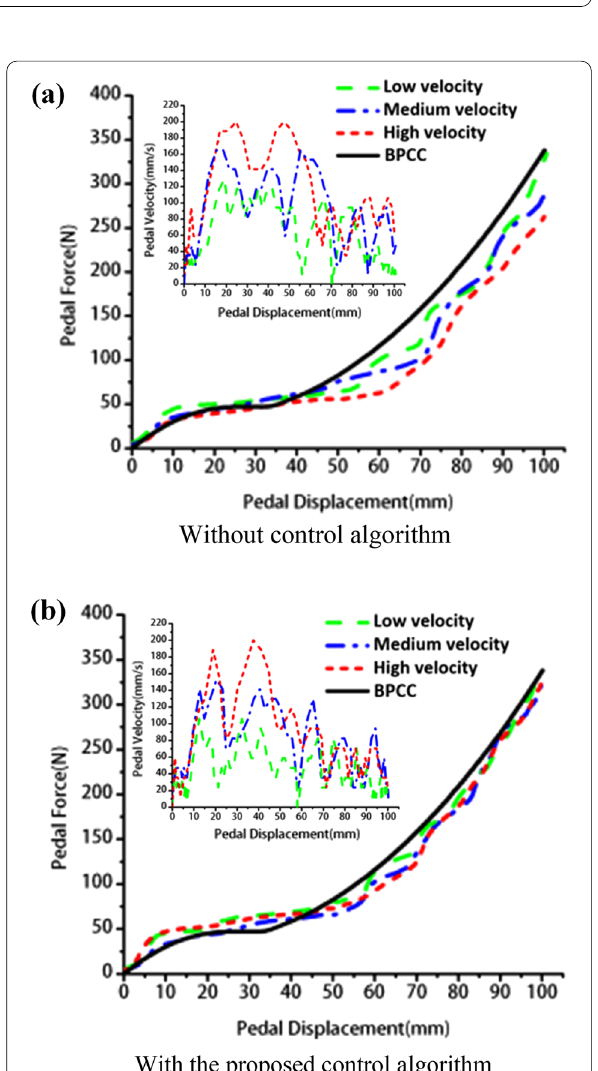
Figure 11 Experimental system: ( a ) Physical map, ( b ) data acquisition and control system